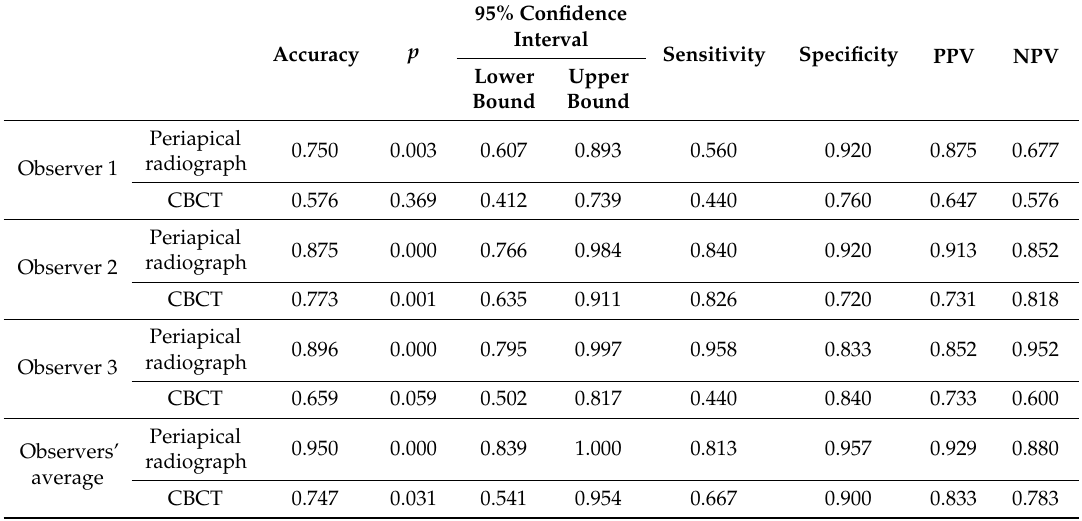
Table 1. Accuracy, sensitivity, specificity, positive predictive value (PPV), and negative predictive value (NPV) values for each observer and observer’s average in detecting separated endodontic files (group 1).